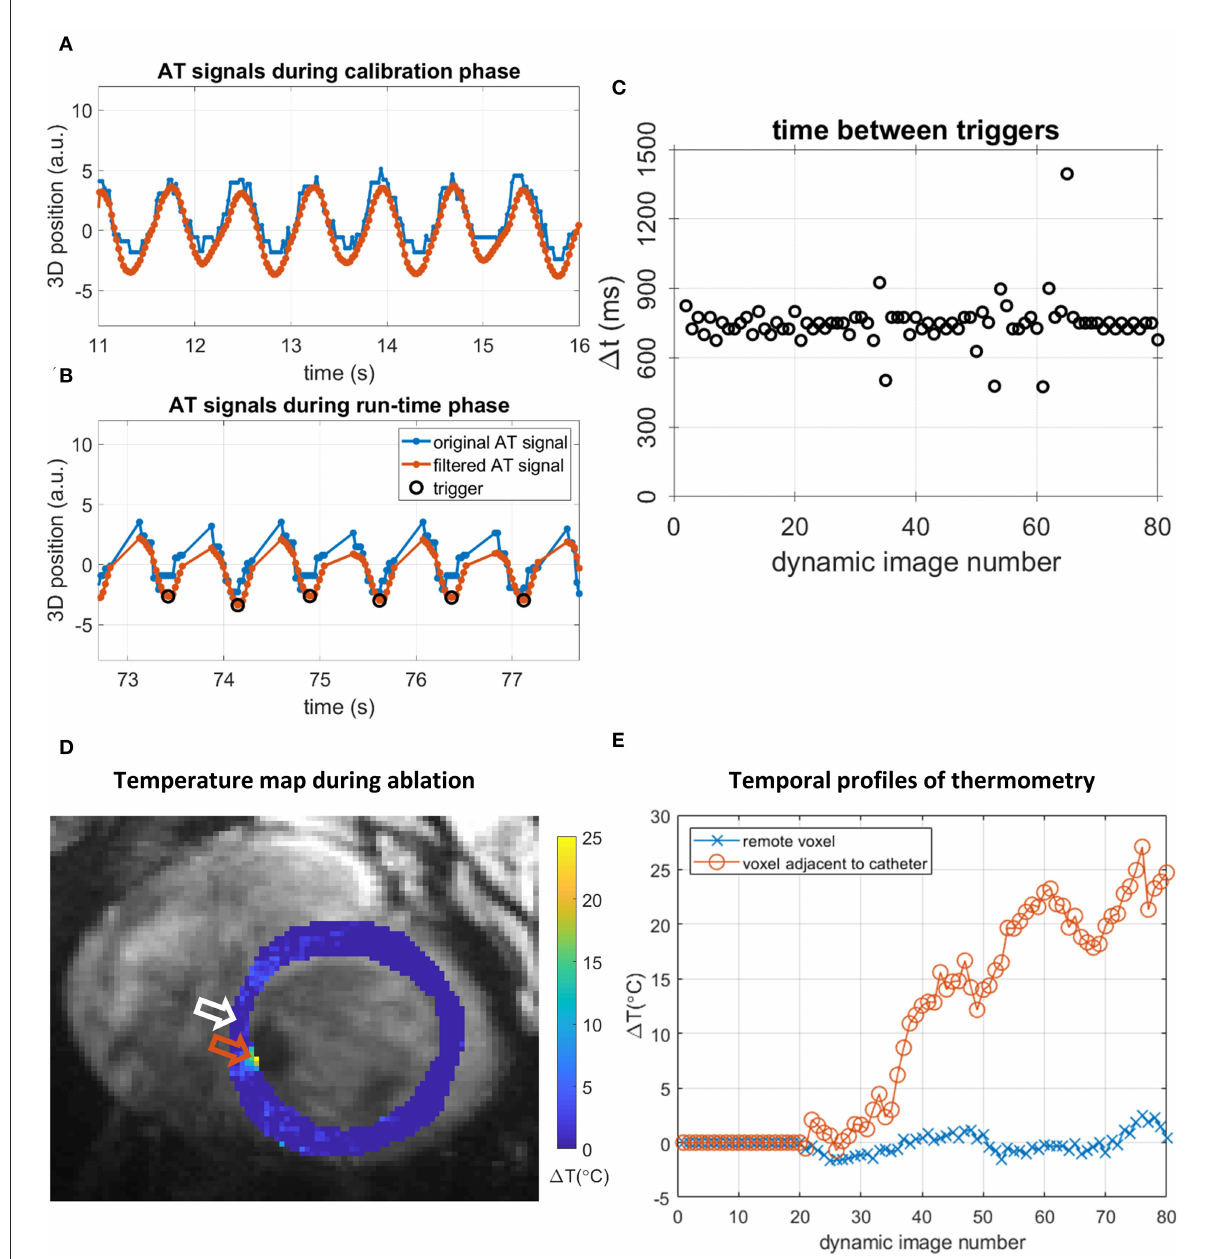
FIGURE9 AT-based cardiac triggering and thermometry data during the RF ablation experiment in position #6 in the LV, using AT valley triggering. (A,B) AT signals and triggers in 5-s segments. Original AT signal (blue), filtered AT signal (orange), and detected triggers (black circles). (A) Continuous AT signal acquired during the calibration phase. (B) AT signal segment during the run-time phase, showing triggers and AT signal interruptions by imaging. (C) Intervals between triggering events (black circles) during the run-time phase. (D) Thermometry map acquired during ablation with AT valley triggering in position 6, 63rd dynamic image. A localized temperature rise is seen near the orange arrow, adjacent to signal void caused by the presence of the catheter in the blood pool. (E) Temporal profile of temperature changes in 2 voxels: a voxel remote from the catheter [white arrow in (D) ] shows temperature changes around 0 ◦ C whereas a voxel adjacent to the catheter [orange arrow in (D) ] displays an elevated temperature during ablation.